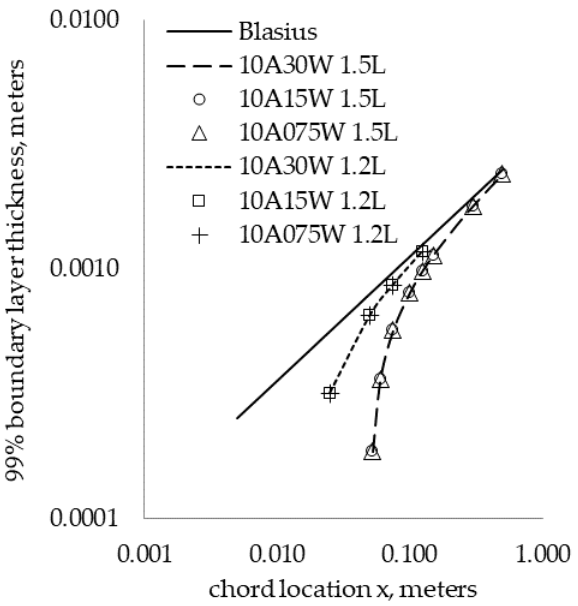
ff erent leading-edge